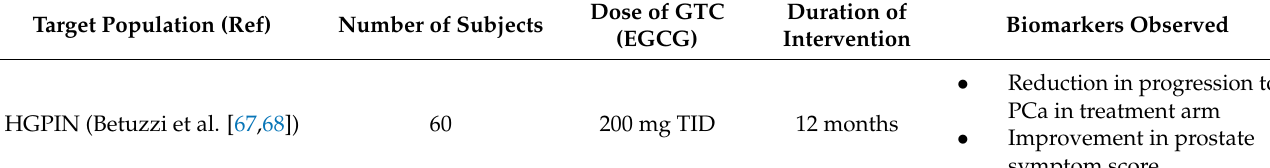
Table 2. Changes in intermediate endpoint biomarkers of PCa observed in Phase II clinical trials using